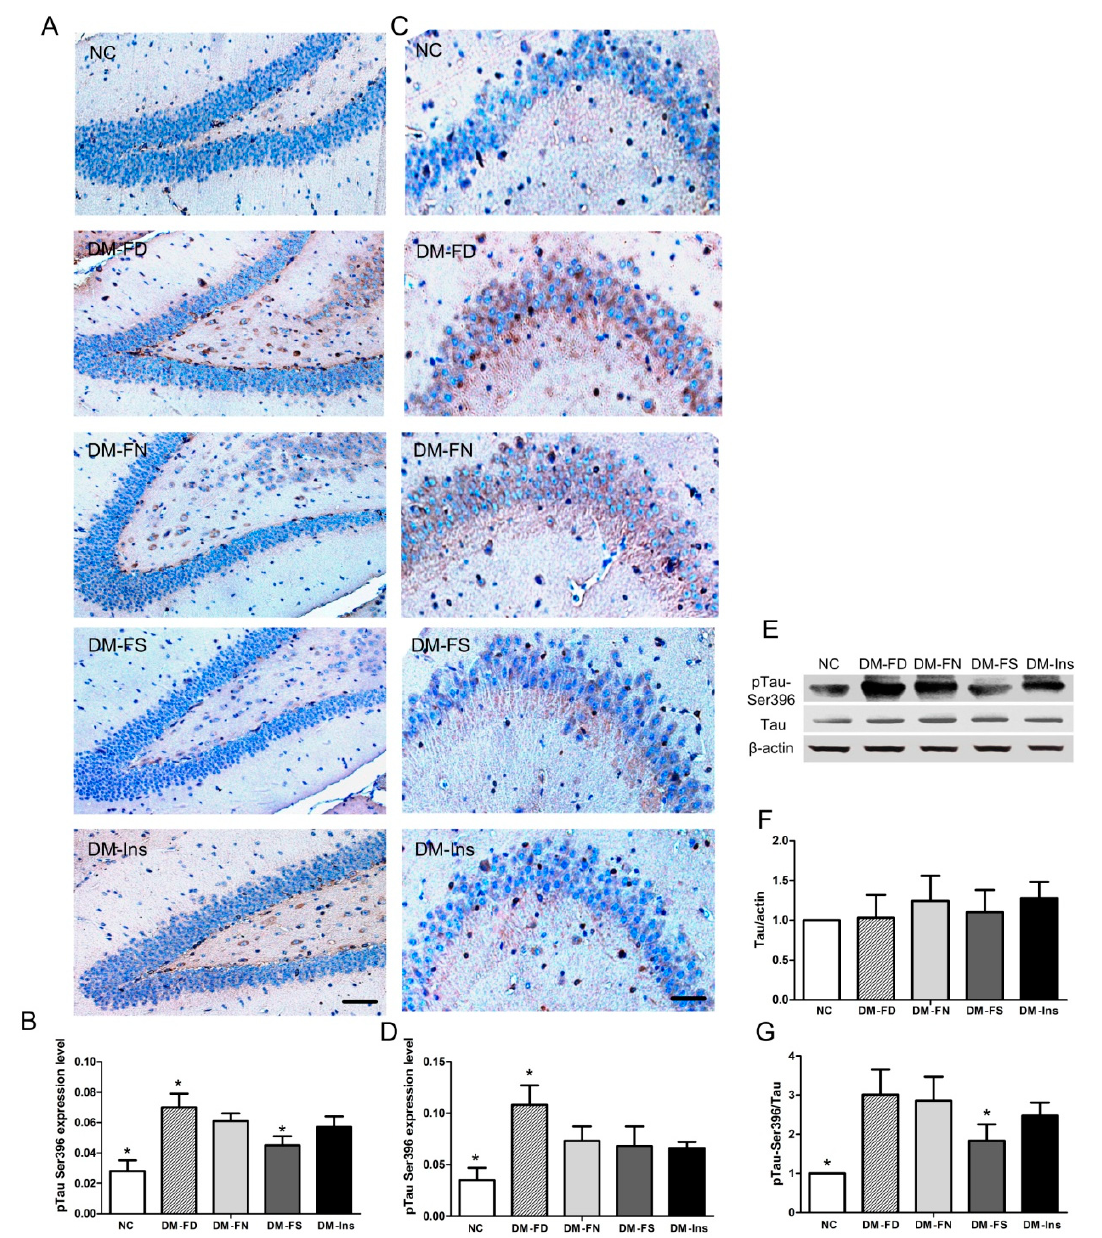
Figure 2. Impact of folic acid on tau phosphorylation in STZ-treated mouse brains. Immunohistochemistry of phosphorylated tau at epitopes Ser 396 in STZ-treated (or Control) mouse brains in CA3 ( A , B ) and DG area of hippocampus ( C , D ). Western blot analysis ( E ) and quantification of total tau ( F ) and phosphorylated tau at epitopes Ser 396 ( G ) in STZ-treated (or Control) mouse brains. The data were expressed as mean ± SD values, n = 5 animals/group. * p < 0.05 versus the DM-FN group. Scale bar = 50 µ m ( A ); Scale bar = 20 µ m ( C ).